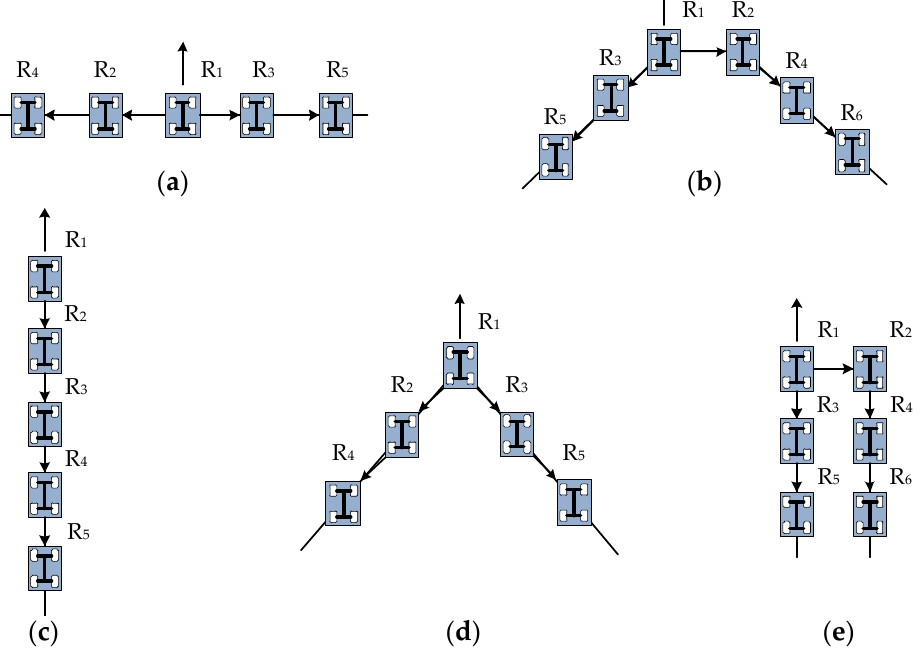
Figure 2. Common multi-robot formation [3]: ( a ) straight line; ( b ) wedge; ( c ) column; ( d ) triangle; ( e ) double row.